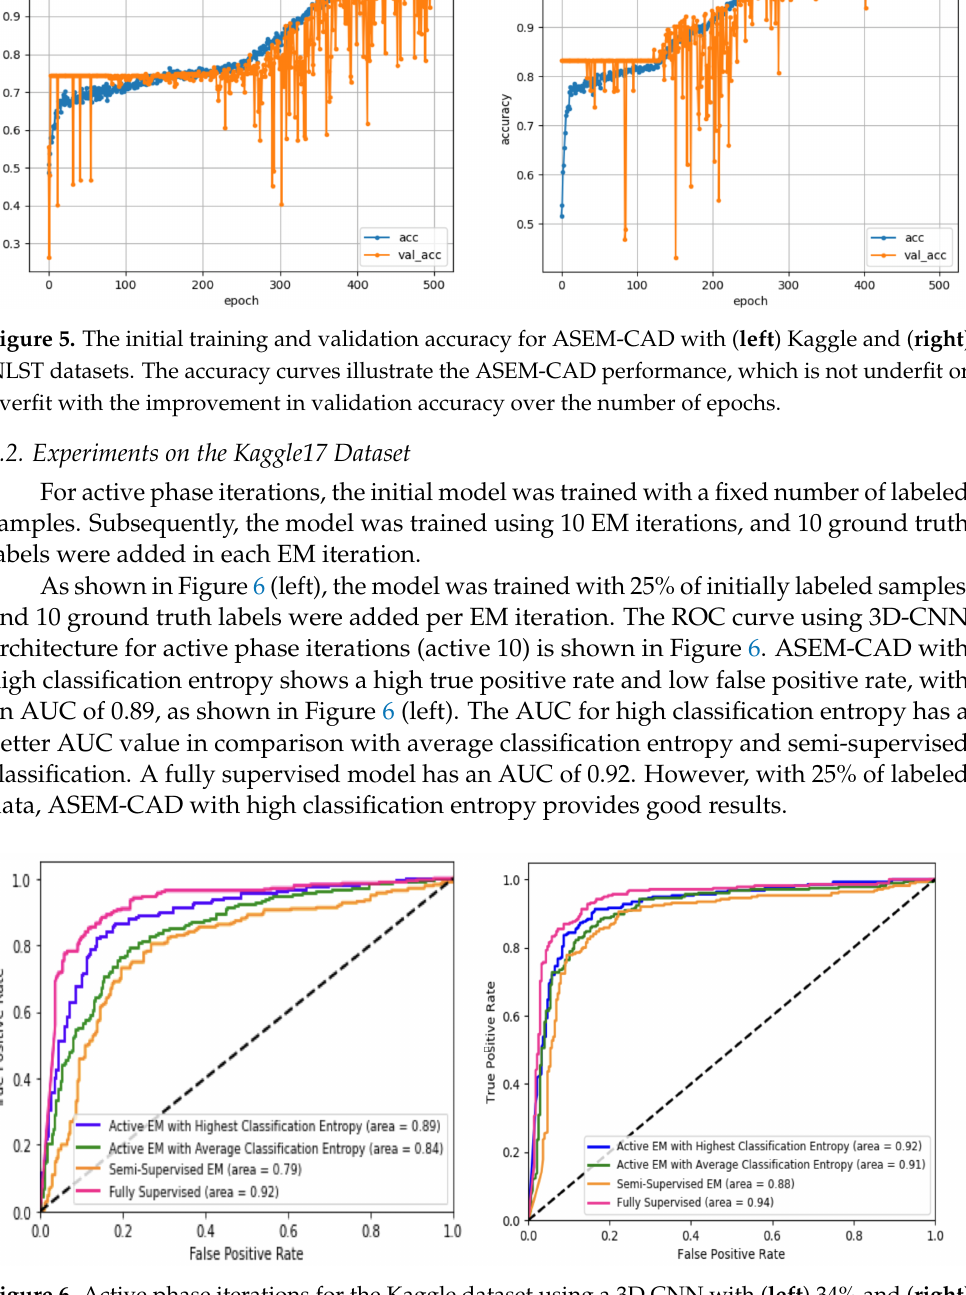
Figure 6. Active phase iterations for the Kaggle dataset using a 3D CNN with ( left ) 34% and ( right ) 59% of training labels. Fully supervised learning using 100% of training